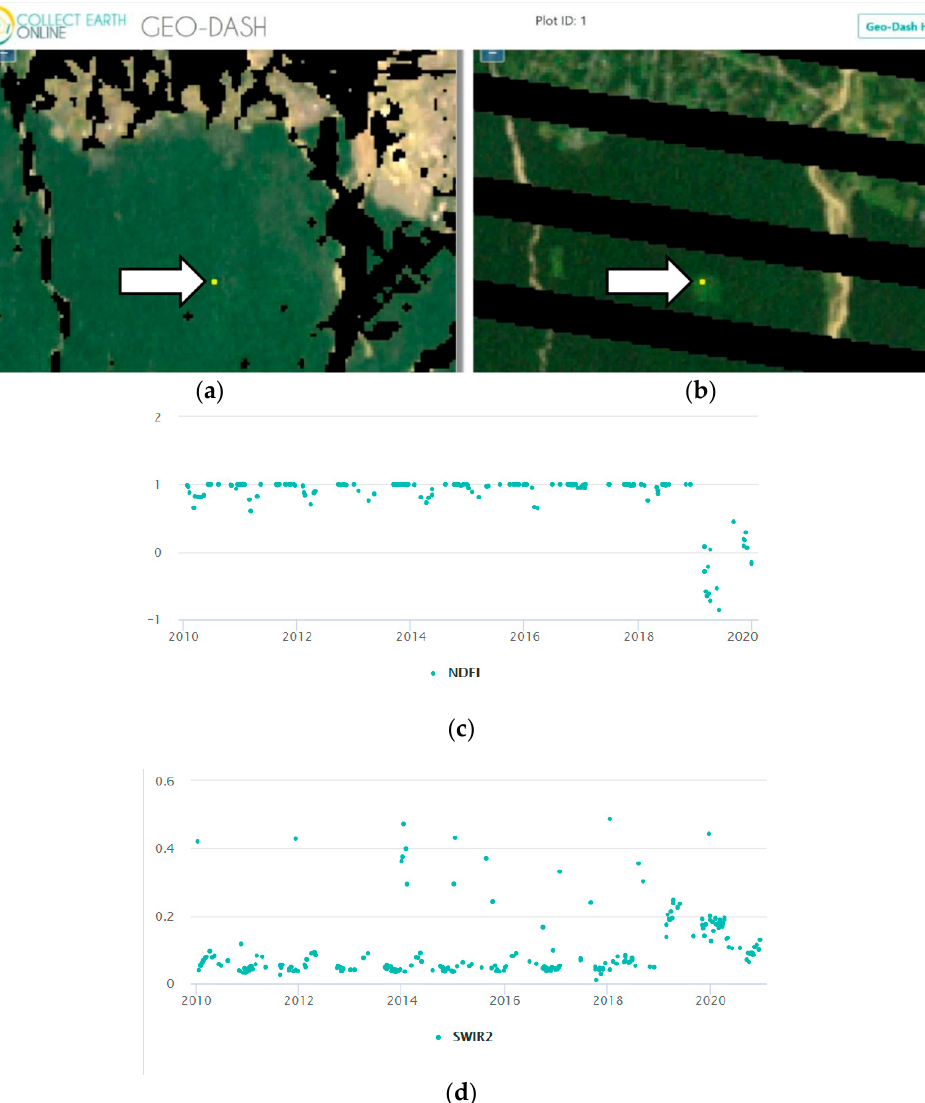
Figure 5. Comparison of NDFI values and SWIR2 values over the same time period for the same location showing the saturation of NDFI in the Terai region. SWIR2 was not used for analysis but is shown here to demonstrate a nonsaturating signal. ( a ) Landsat image from 1 May 2018; yellow dot shows plot location. ( b ) Landsat image from 19 September 2020; yellow dot shows the same plot location. ( c ) Time series chart of NDFI values from 2010 to 2020. ( d ) Time series chart of SWIR2 values from 2010 to 2020.